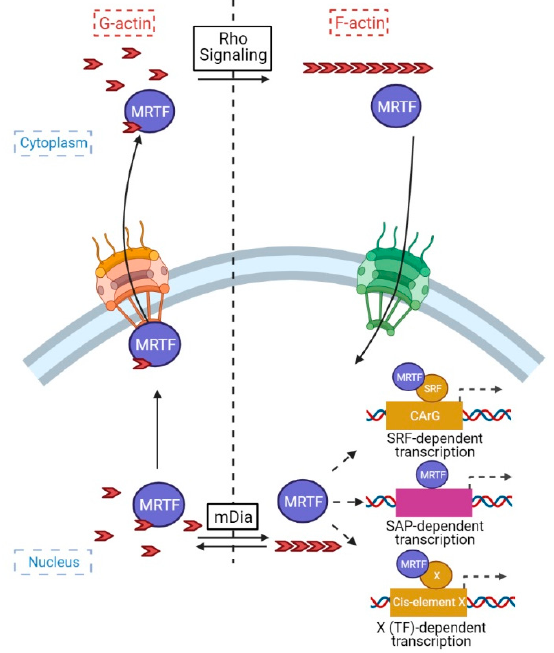
Figure 1. The regulation of MRTF subcellular localization and transcriptional activity by the actin cytoskeleton MRTF-A/B are transcriptional coactivators regulated by F/G actin ratio. Cytosolic G-actin binds MRTF masking a Nuclear Localization Sequence (NLS) (see Figure 2). Activation of small Rho GTPases promotes F-actin polymerization, thereby reducing the cytosolic G-actin pool, and causing G-actin to dissociate from MRTF to unmask the NLS, which enables importin α / β -dependent nuclear translocation. In the nucleus (1) MRTF binds SRF forming the MRTF/SRF complex which induces the transcription of various genes (SRF-dependent transcription); (2) MRTF can independently facilitate transcription of genes via its SAP domain (SAP-dependent transcription); and (3) MRTF can bind other TFs (e.g., smad3, TAZ) which induce transcription via alternative non- CArG dependent cis-elements. Additionally, the nuclear F/G actin ratio regulates MRTF function. Increased mDia activity enhances MRTF/SRF transcriptional activity, while nuclear G-actin binding to MRTF supports CMR1-dependent nuclear export. Together, the actin cytoskeleton acts as an integral regulator of MRTF-dependent gene expression (dotted arrows). (Created with BioRender.com, accessed on 15 April